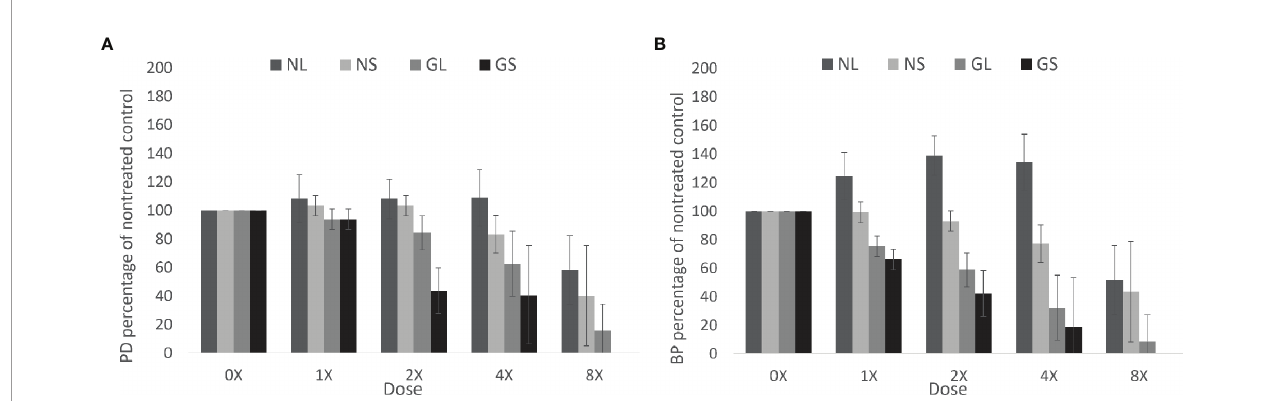
FIGURE 3 | Effect of genotype and seed size on response of snap bean to sulfentrazone dose. (A) Plant density as a percentage of the nontreated control. (B) Dried biomass per plant as a percentage of the nontreated control. NL, Navarro seed class extra-large; NS, Navarro seed class extra-small; GL, Goldmine seed class extra-large; GS, Goldmine seed class extra-small. Error bars represent one standard deviation from the mean of the category and